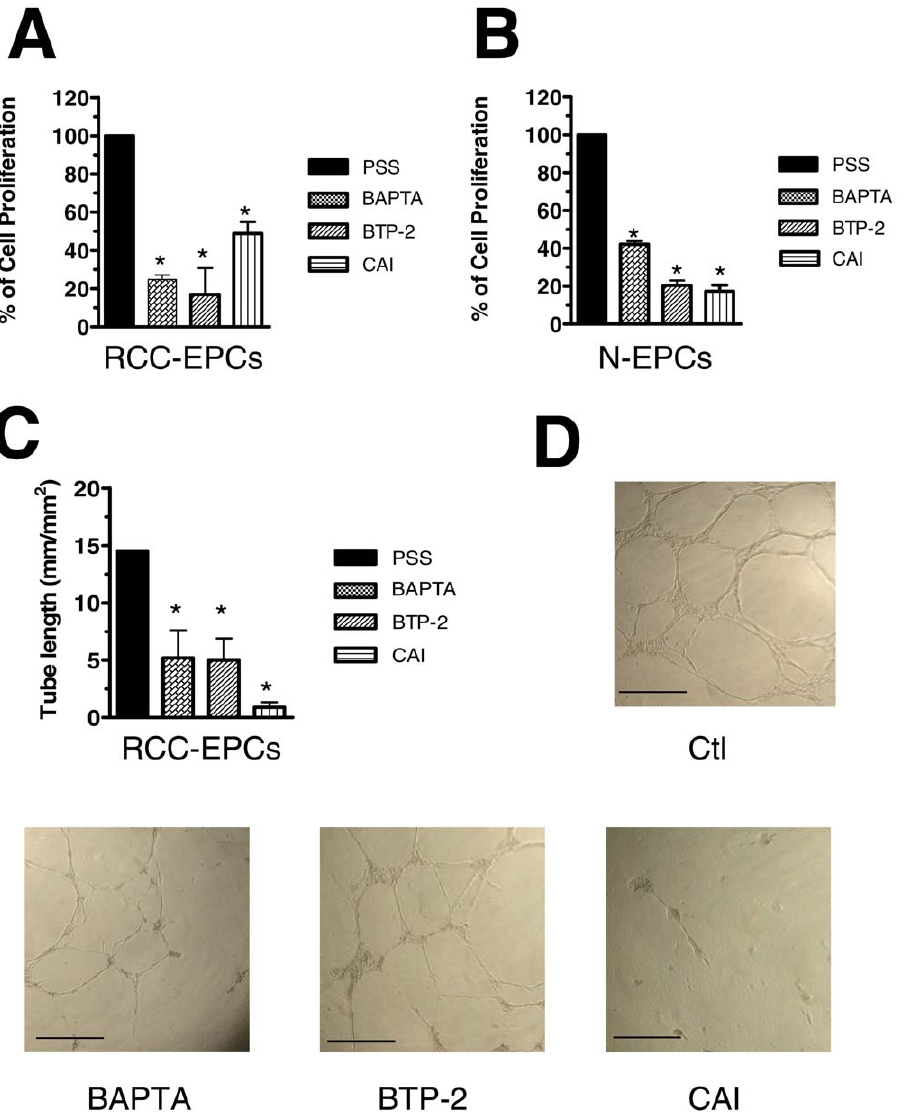
Figure 10. The effect of BAPTA, BTP-2, and carboxyamidotriazole on proliferation and tubulogenesis of endothelial progenitor cells. BAPTA (30 m M), BTP-2 (20 m M), and CAI (10 m M) block the proliferation of both RCC-EPCs (A) and N-EPCs (B). The effect of BTP-2 on N-EPCs has already been shown in [27]. Results are expressed as percentage of growth compared with control (given as 100% growth). C, statistical evaluation of the block exerted by BAPTA (30 m M), BTP-2 (20 m M), and CAI (10 m M) on the assembly into tubulary-like structures of RCC-EPCs. D, digital images of endothelial tubes obtained by bright-field light microscopy 10 hours after plating the cells in Matrigel under control conditions (upper Panel), and in the presence of BAPTA (30 m M), BTP-2 (20 m M), and CAI (10 m M). Cultures were observed up to 24 ours but their appearance did not substantially change after pictures were taken. The bar length is 250 m M.